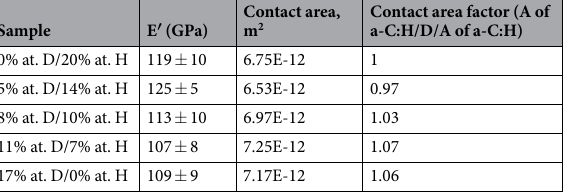
Table 2. Reduced elastic modulus (E ′ ), the contact area calculated by using the Hertz’s Theory (equations 1 and 2) and the contact area factor with a normal load (W) of 10 mN and a radius of the spherical dome of the diamond conical tip (RA) of 25 μ m.